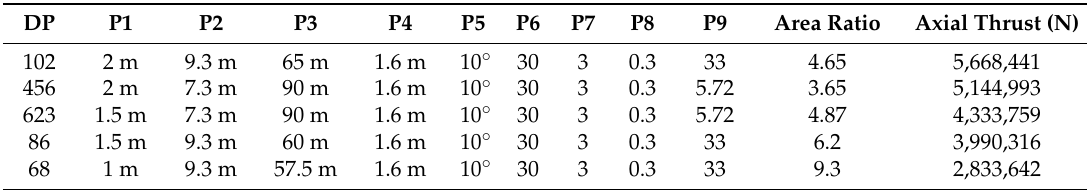
Table 8. Maximum axial thrust for varying nozzle area ratios of